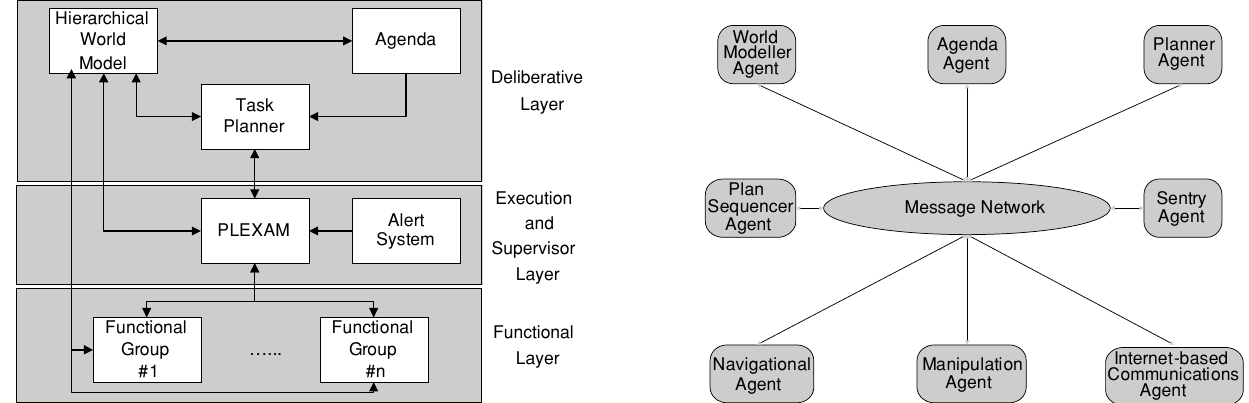
Figure 1 (Left) A scheme of a hybrid robotic architecture (ACHRIN (Galindo et al. in press)). (Right) Its evolution to a multi-agent system. Notice that in a client/server system (left) the addition of a component implies the modification of the components connected to it, which does not occur in a MAS. In our multi-agent re-design of ACHRIN, we have considered navigation, manipulation and Internet-based communication (access to email, for instance) as the functional tasks carried out by the combined human–robot